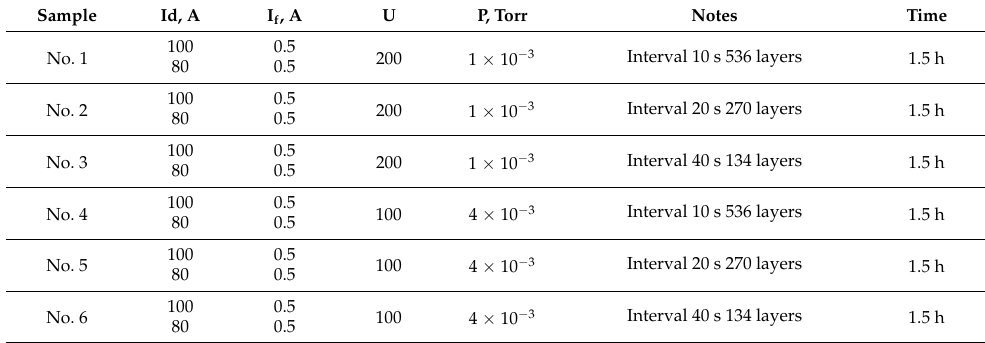
Table 1. Deposition conditions for (TiZr/Nb)N coatings using the Arc-PVD method.